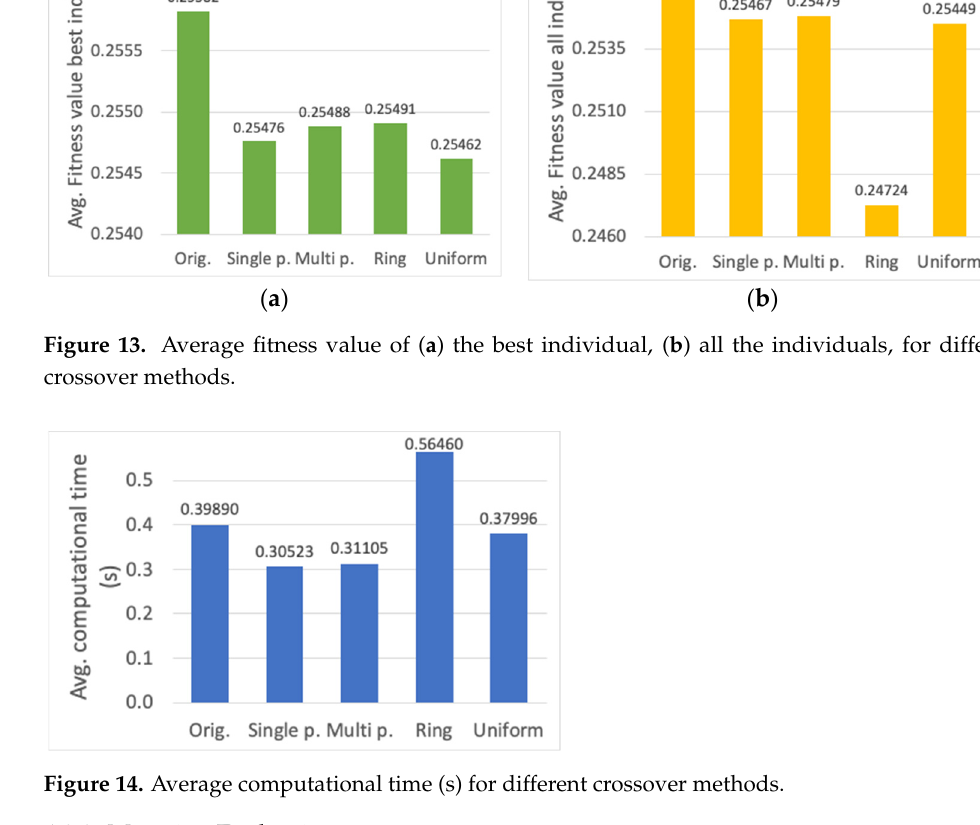
16 of 24 Figure 12. Average computational time (s) for different parent selection algorithms. 4.3.2. Crossover Evaluation Next, the analysis of crossover alternatives is performed (cf. Section 3.3). Again, eval- uation results are shown for the average fitness value of the best individual, of all the individuals in the final population, and the average computational time (Figures 13a,b and 14, respectively). The different methods are compared with the original mechanism used, in which all the individuals provide certain number of genes to the new offspring proportional to their corresponding fitness value. The ring crossover method shows the